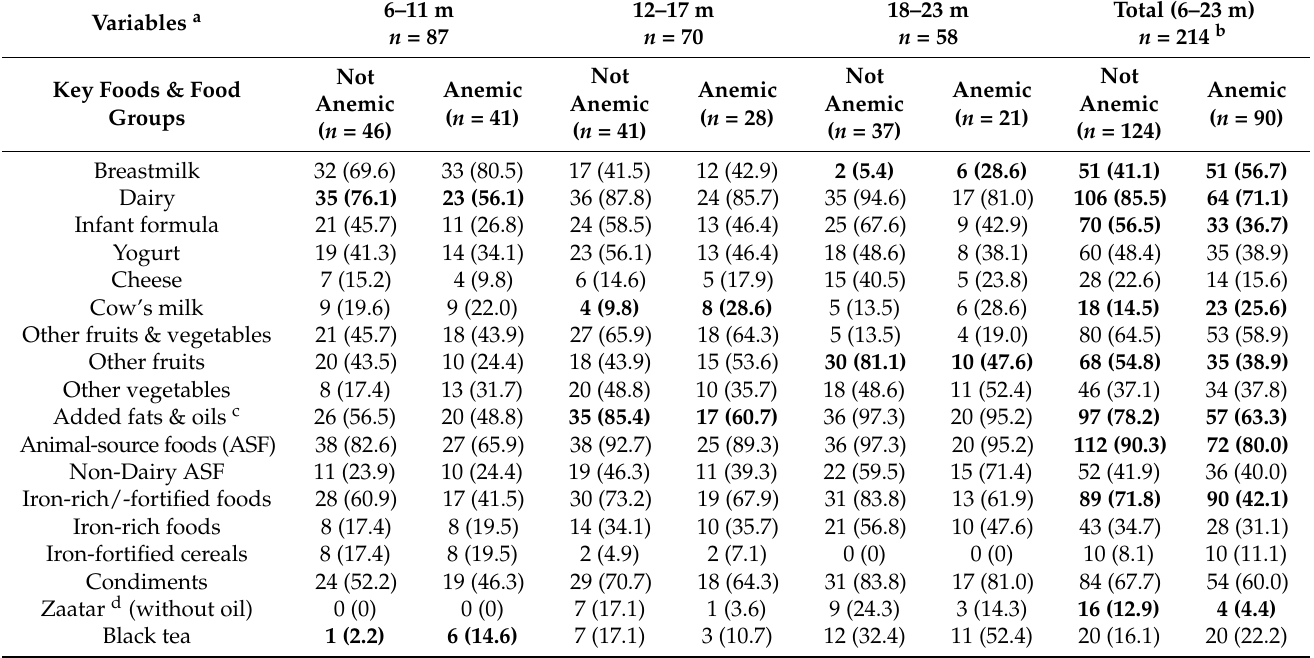
Table 5. Dietary intake of key foods and food groups of Syrian refugee children aged 6 to 23 months according to age and anemia status (24-h DR